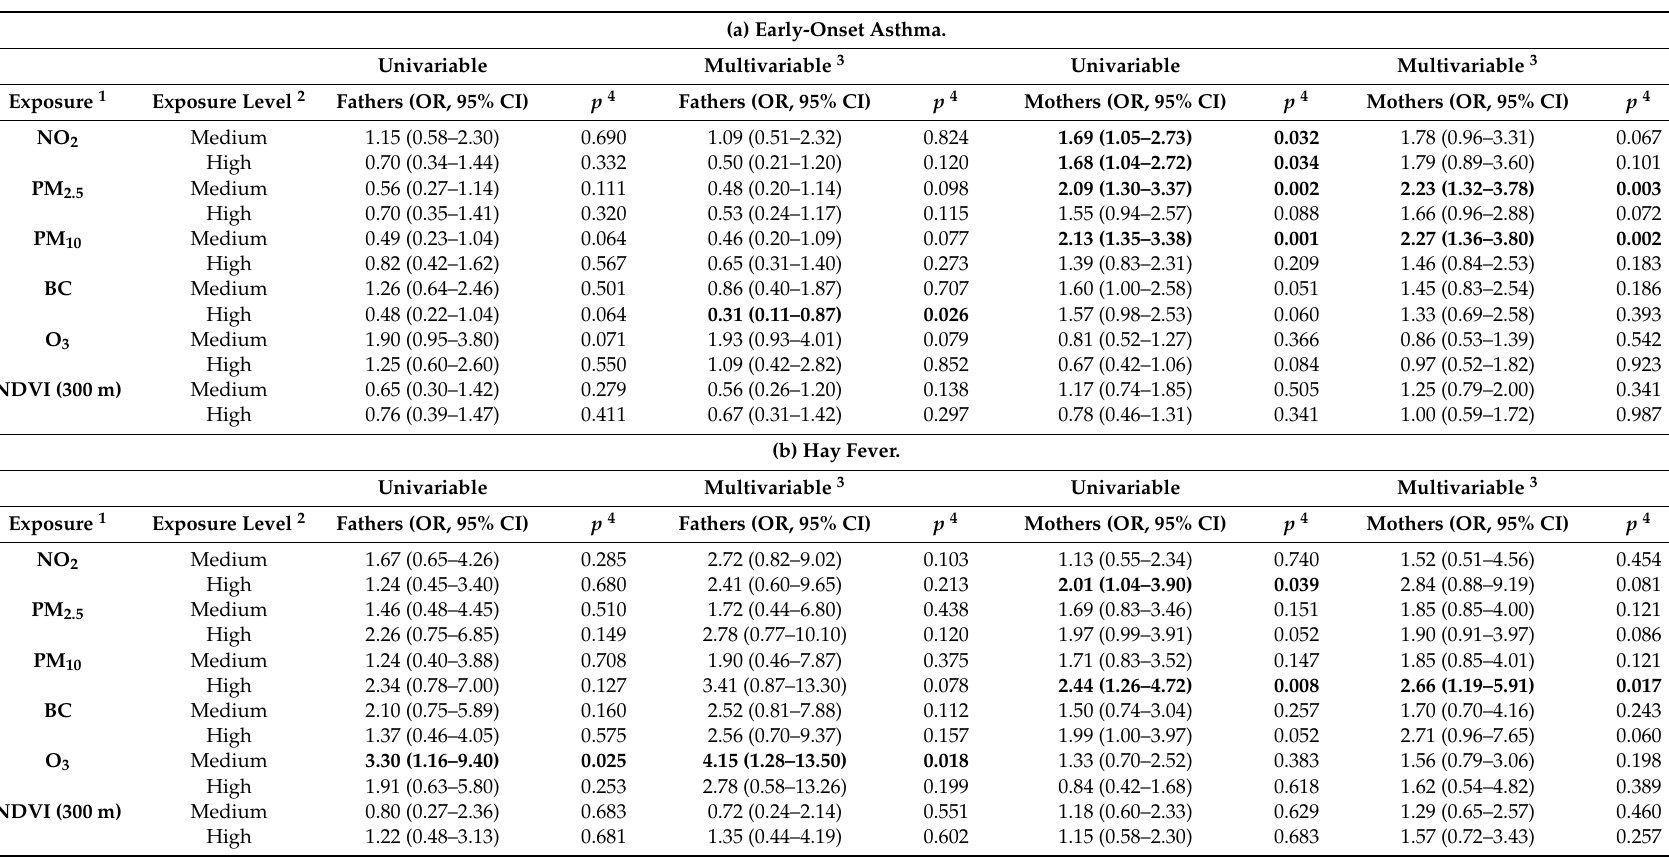
Table 2. Univariable and multivariable analyses: associations between paternal ( N = 400) and maternal ( N = 706) exposure to air pollutants and NDVI and o ff spring ( N = 1949) early-onset asthma (a) and hay fever (b) in the RHINESSA generation study. (a) Early-Onset Asthma.